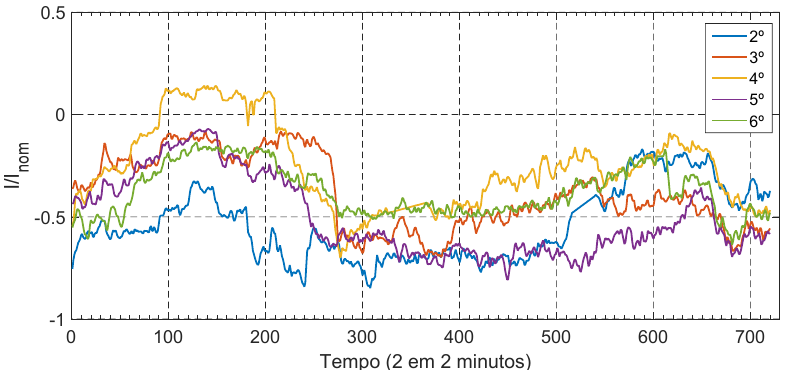
Figure 25. Second week of February: evolution of load factor for different working days (2nd to 6th), presenting a similar pattern as the first week.